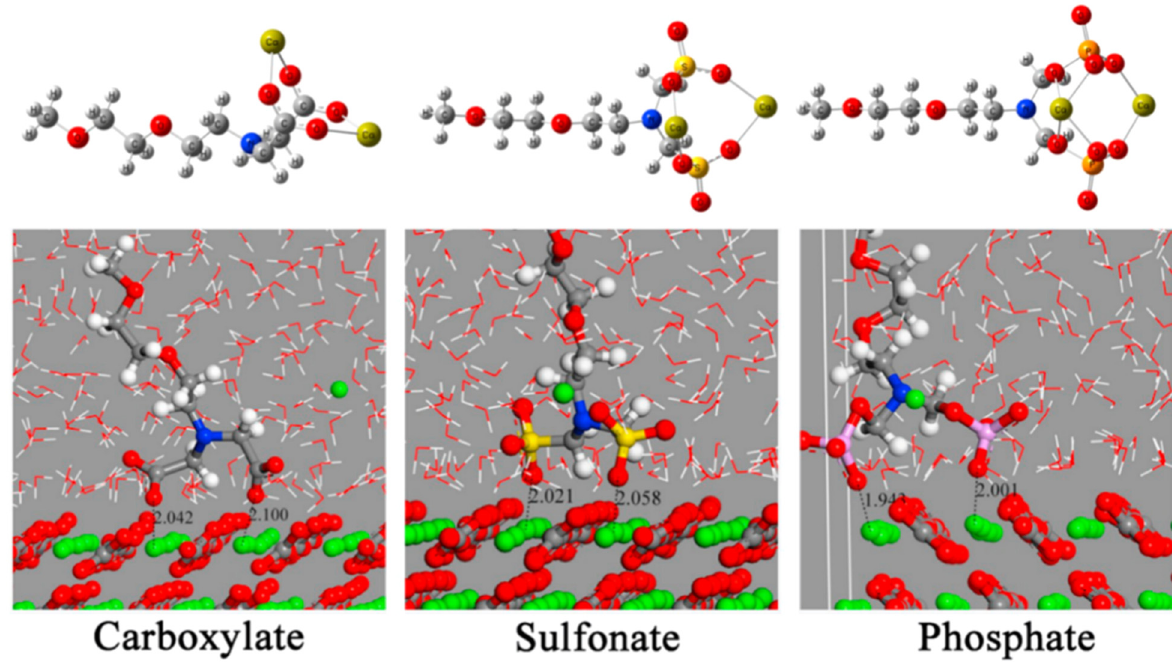
Figure 12: The complexes of three monomers ( carboxylate, sulfonate, and phosphate ) with Ca 2 + , reprinted with permission from ref. [ 121 ] ; Copyright 2019, Elsevier